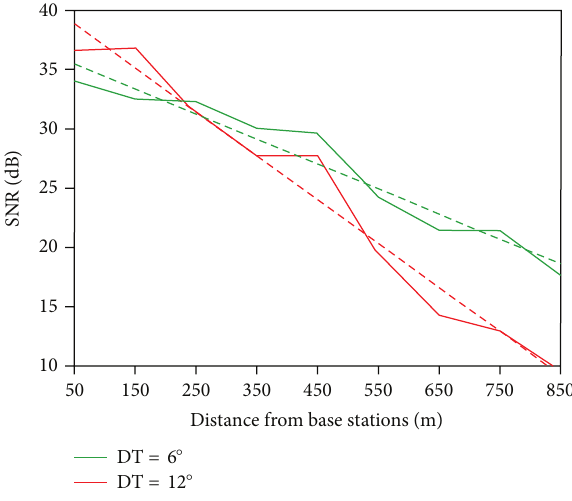
Figure 12: Numbering scheme for wideband beams at first site in a CA.